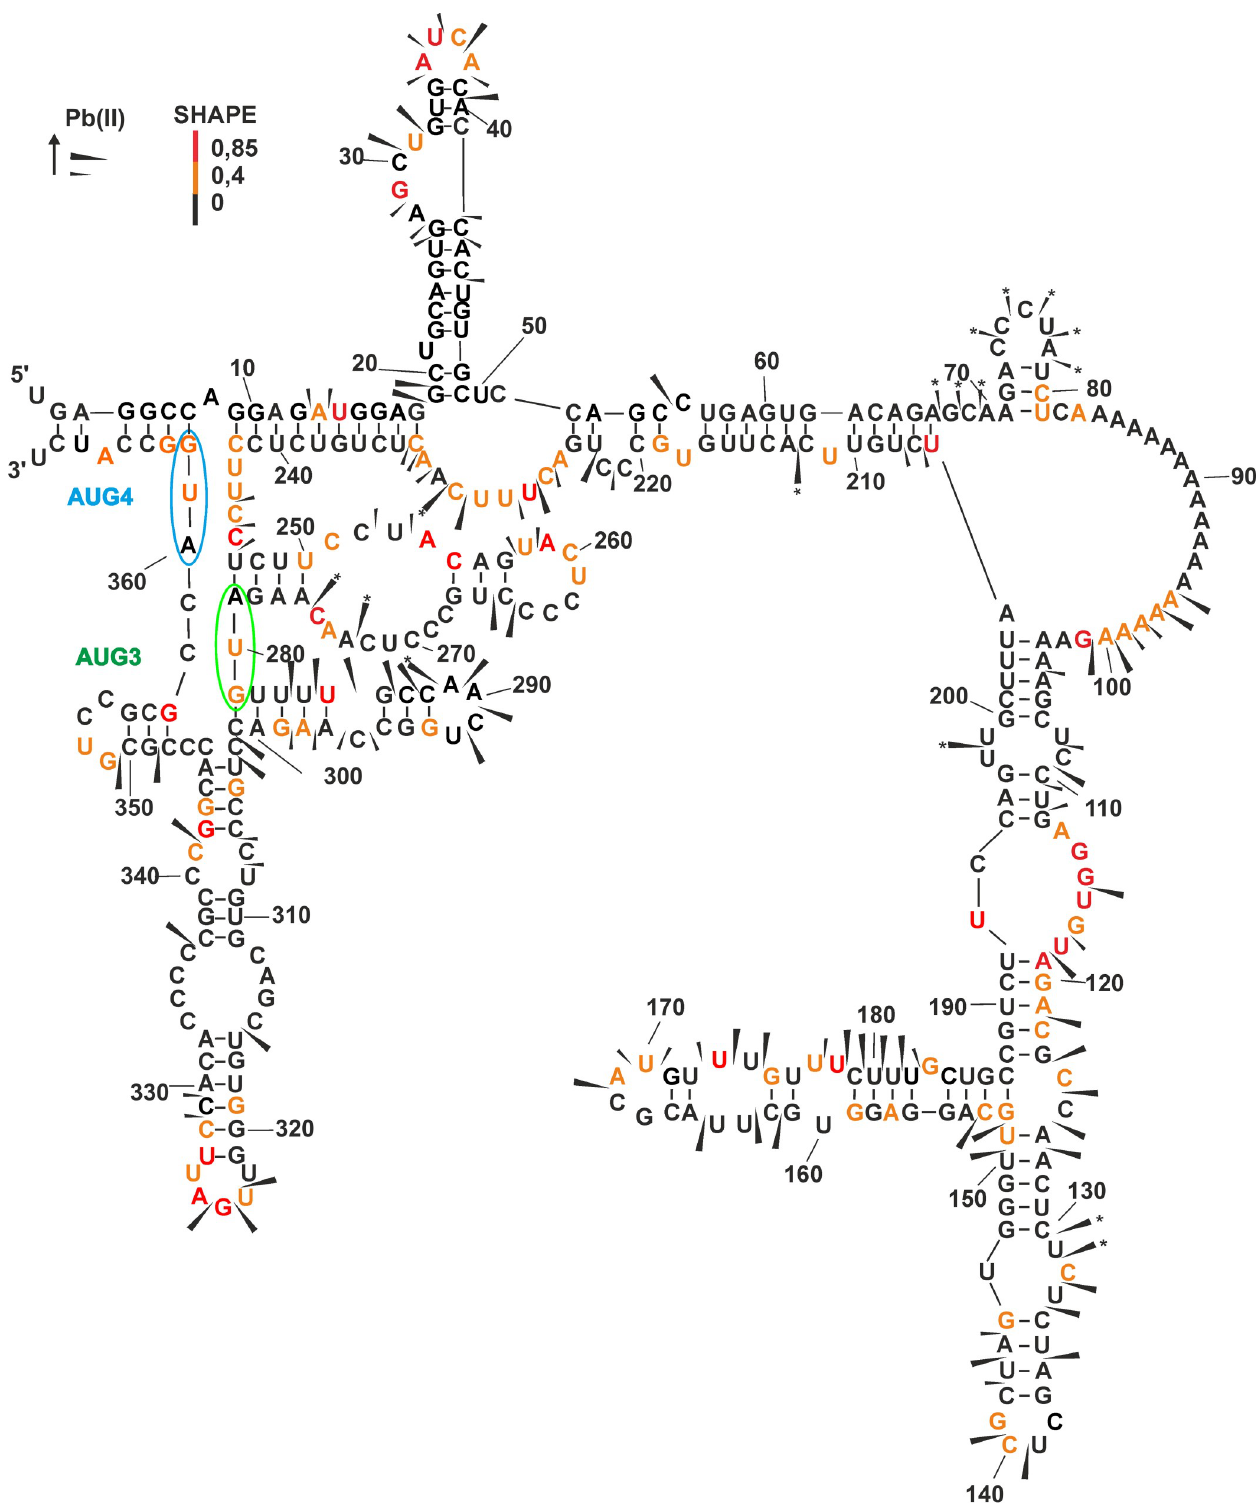
Fig 1. The secondary structure model of 5 0 -terminal region of Δ 133p53 mRNA analyzed by Pb 2+ -induced cleavage and SHAPE. A secondary structure model corresponding to experimental data was generated by RNAstructure 5 . 6 software. Nucleotide symbols are marked with colors according to their SHAPE reactivity. Cleavages induced by Pb 2+ ions are displayed on the secondary structure model with arrows. Arrows with an asterisk � indicate RT-stops. The green loop in the model denotes AUG3 initiation codon for Δ 133p53 isoform and the blue loop marks AUG4 for Δ 160p53 isoform. https://doi.org/10.1371/journal.pone.0256938.g001 PLOS ONE | https://doi.org/10.1371/journal.pone.0256938 September 7,